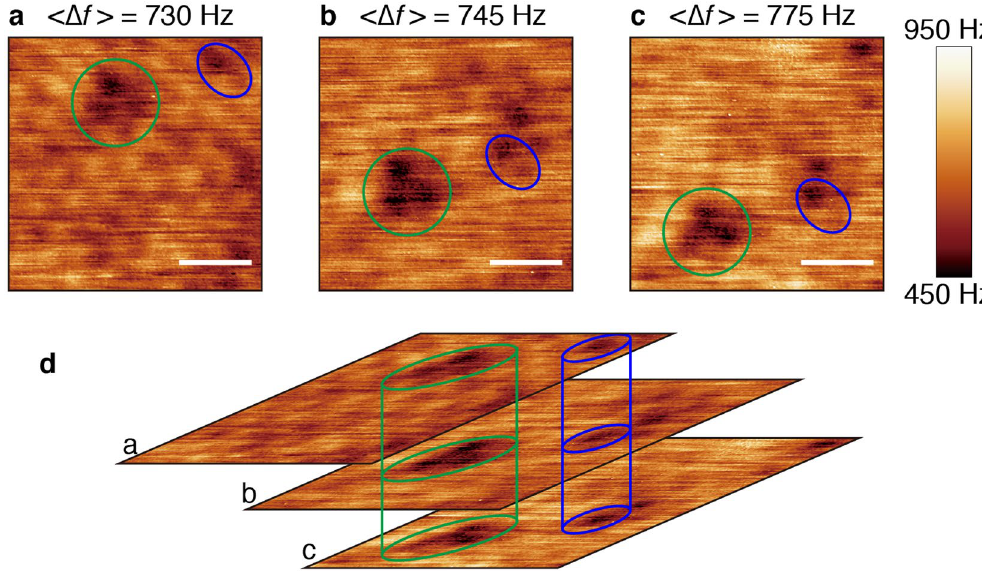
Figure 4. FM-AFM ( ∆ f ) images on muscovite surface covered with a thin water film with low lateral thermal drift. ( a ) < ∆ f > = 730 Hz. ( b ) < ∆ f > = 745 Hz. ( c ) < ∆ f > = 775 Hz. The green and blue circles mark the same lateral positions with dark contrast on the muscovite surface. The white scale bar represents 1 nm. ( d ) Vertical superimposition of the images in ( a–c ), with the alignment of each of the positions marked by the coloured circles. The dark regions penetrate through multiple water layers. The resonant frequency, spring constant, and oscillation amplitude of the cantilever were 342.5 kHz, 48 N/m, and 0.46 nm, respectively. The scanning time was 15 sec per image. The time intervals between a and b , and between b and c , were 114 sec and 53 sec, respectively. The averaged drift velocity was 2.5 pm/s for the x -direction, and − 11 pm/s for the y